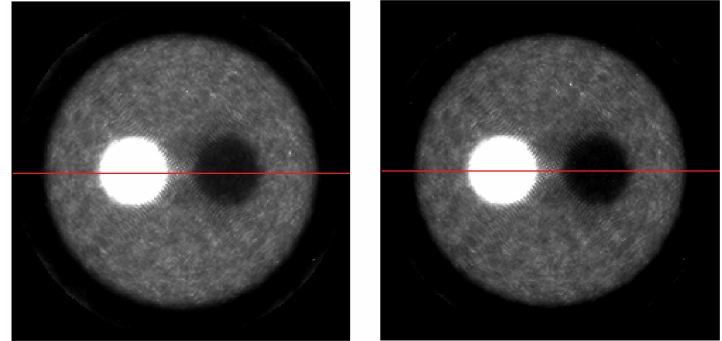
Figure 6. Reconstructed images of the Utah phantom using LM-OS with 4 iterations and 3 subitera- tions: ( left image ) Without scatter correction; ( right image ) scatter corrected using the information of the upper and low energy windows (TEW method).